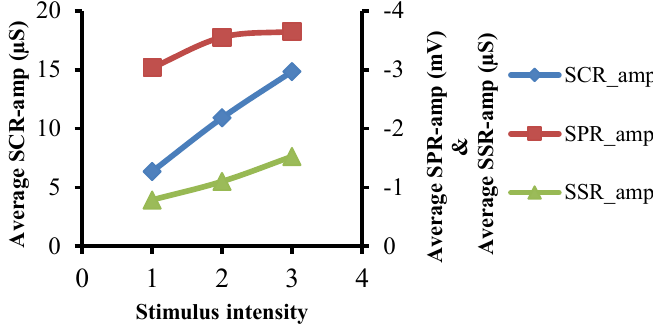
Fig. 4: Shows relation between average values of amplitudes of SCRs, SPRs and SSRs on one side, and the stimulus intensity on other